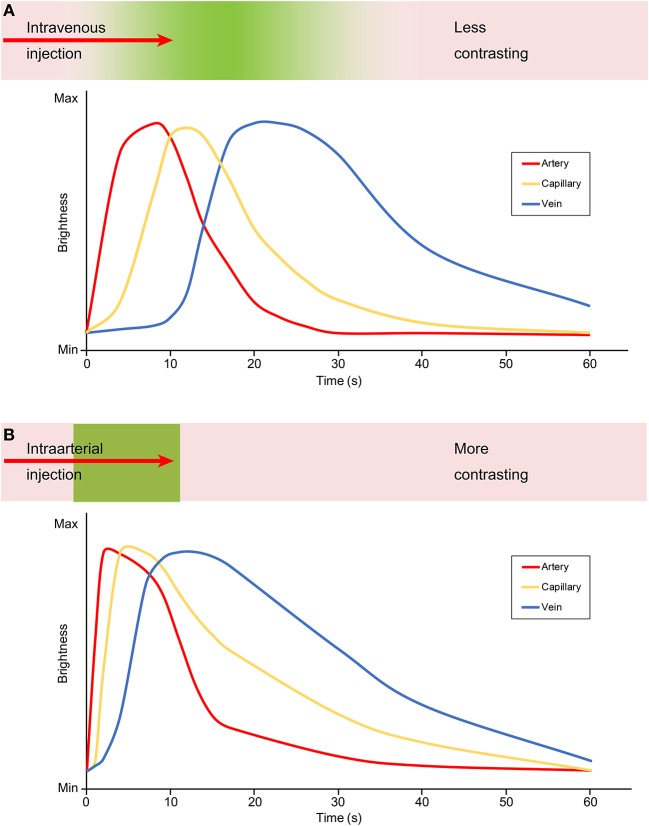
Graphic demonstrating the contrast and brightness changes during angiography with an (A) intravenous and (B) intraarterial FNa injection. The green color embedded in the bar above the graph represents the flow of the fluorescein. With an intravenous injection, the fluorescein is diluted and contrasts less as shown in the less steep and delayed graph, compared with an intraarterial injection during which the fluorescein is more concentrated and contrasts better as shown by the steep and acute graph. Max, maximum; Min, minimum. Used with permission from Barrow Neurological Institute, Phoenix, Arizona.